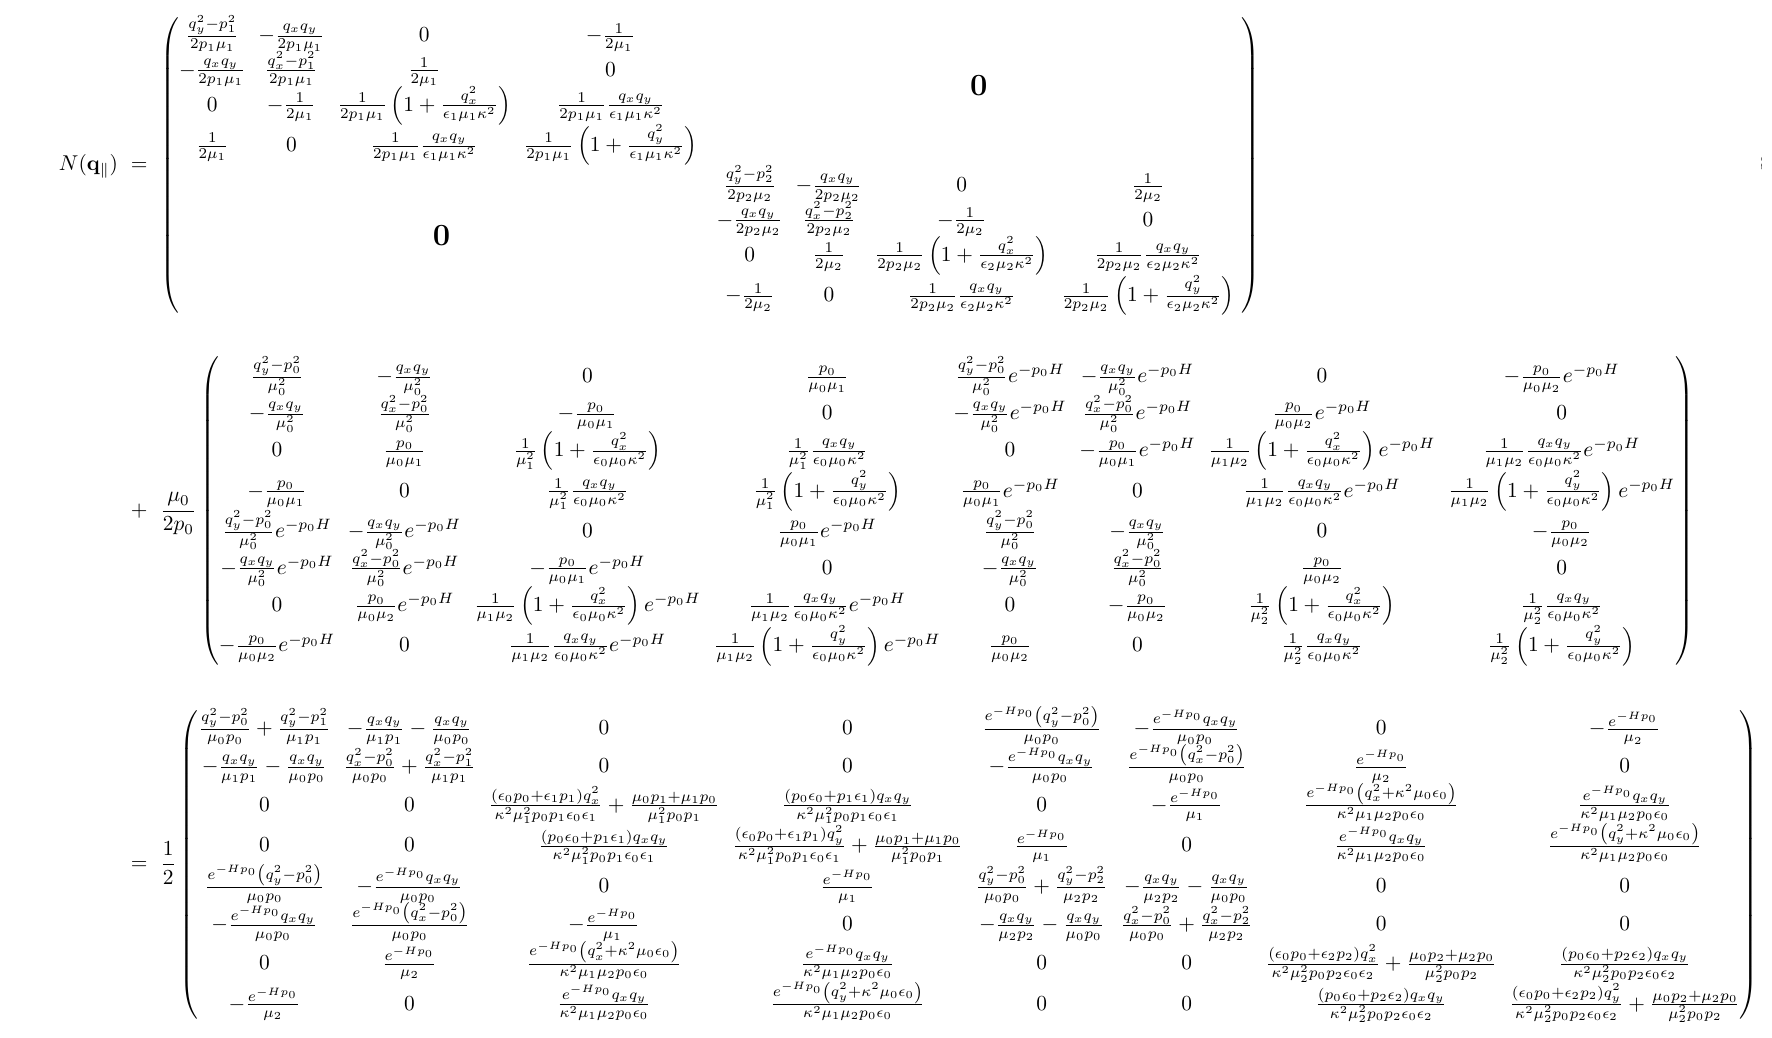
) forming the diagonal blocks of the matrix N Figure 2. Matrix N ( q (cid:107)